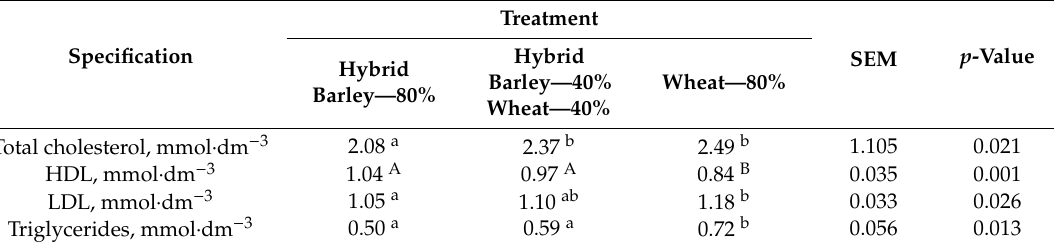
Table 5. Lipid indicators determined in blood serum of